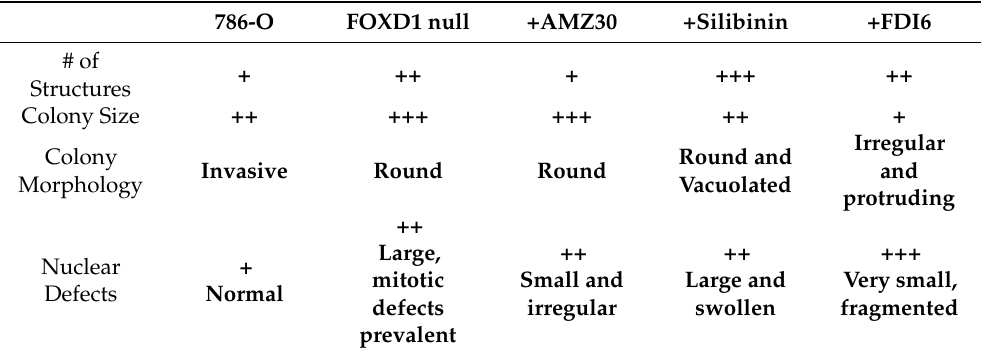
Table 3. Key FOXD1 related effects analyzed in 786-O cells. Summary of results from analysis of 3D growth of 786-O treated with chosen compounds compared to 786-O FOXD1, with descriptions. + = less, ++ = more, +++ = most.